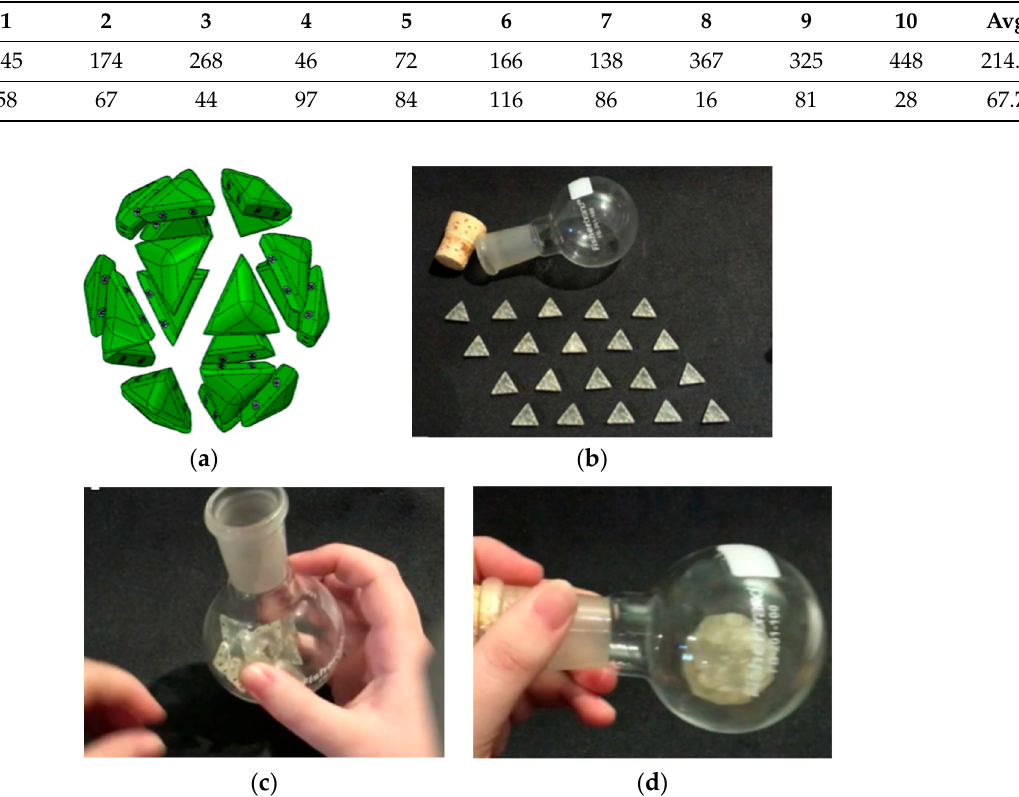
Figure 9. Four successive images from our design of the twenty 3D printed subunits to the self- assembly of the icosahedron in a spherical flask. ( a ) The 20 individual subunits. ( b ) The 20 3D printed subunits laid out on a table before putting into a vessel. ( c ) We found that a spherical vessel (Cook et al. [27]) was more conducive to ( d ) assembling polyhedra than in a cylindrical or an Erlynmeyer flask. See Supplemental Movie S1 and Table 3.